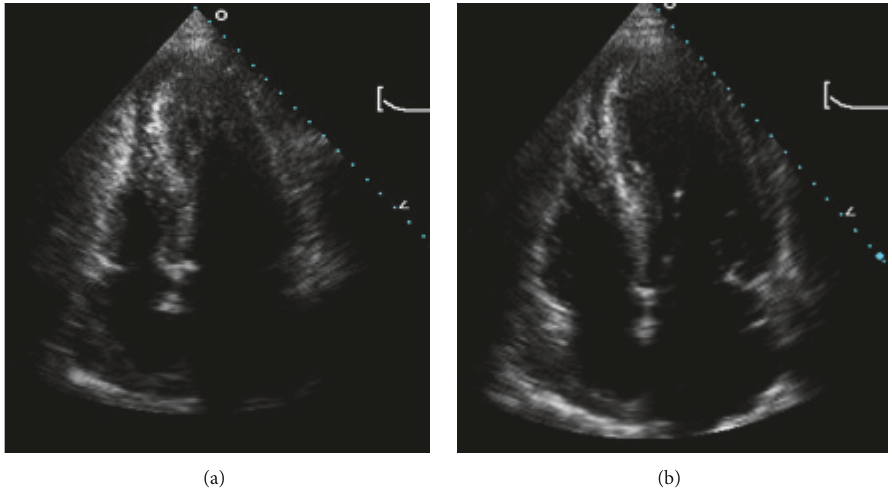
Figure 4: (a) and (b): patient’s baseline echo showing asymmetric septal hypertrophy in systole and diastole, respectively.